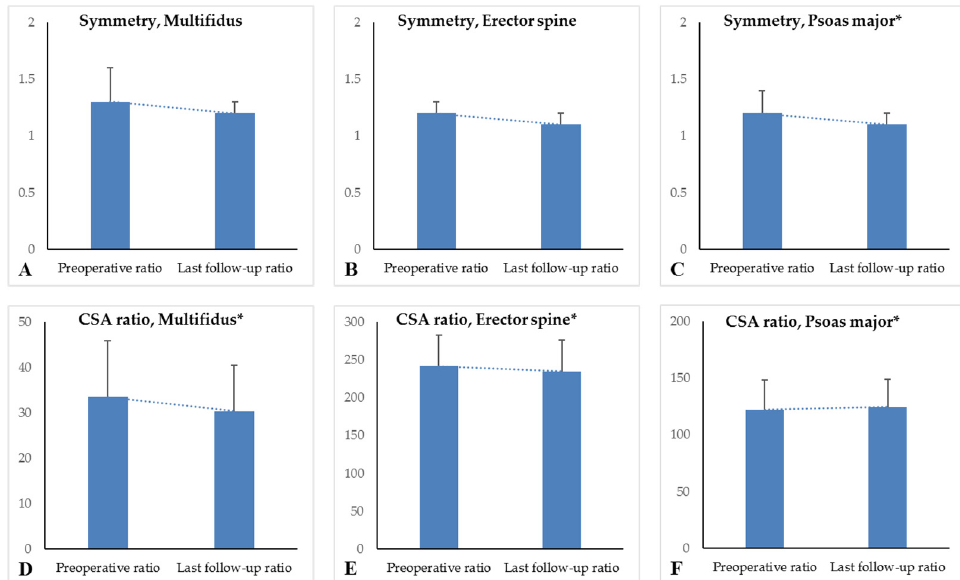
Figure 2. Symmetry difference between preoperative and last follow-up data. Symmetry was compared by ratio between large and small CSAs in the right and left paraspinal muscles. Only the symmetry of the psoas muscles showed statistical significance ( A – C ). The CSA ratio between preoperative and last follow-up data ( D – F ). Only the CSA ratio of the psoas muscle increased, from 122% to 124%, with statistical significance. * means statistical significance ( p < 0.05).